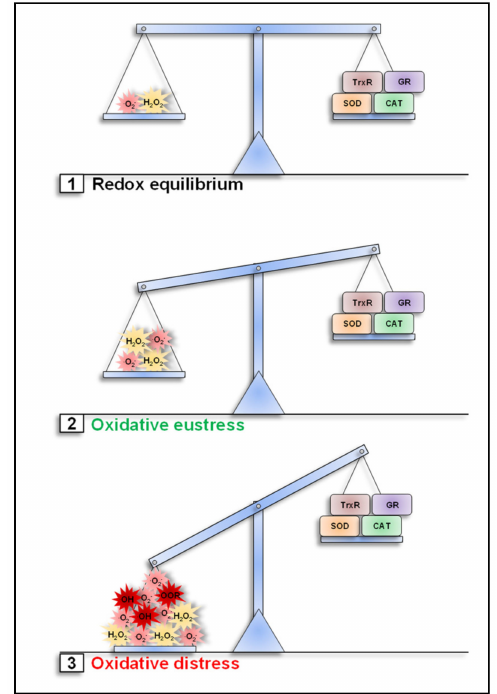
Figure 2. The redox status of the cell is influenced by ROS production on the oxidative side and the antioxidant defense system on the reductive side. ( 1 ) If ROS producing and eliminating factors are in equilibrium, redox balance is achieved, which represents the normal status in cells. ( 2 ) ROS production can be increased and exceed the capacity of the antioxidant defense system. If excess ROS fulfill important cellular functions, this is called oxidative eustress. ( 3 ) Continuous ROS production beyond the level required for cellular functions leads to oxidative damage and is called oxidative distress. Thioredoxin reductase (TrxR), glutathione reductase (GR), superoxide dismutase (SOD), catalase